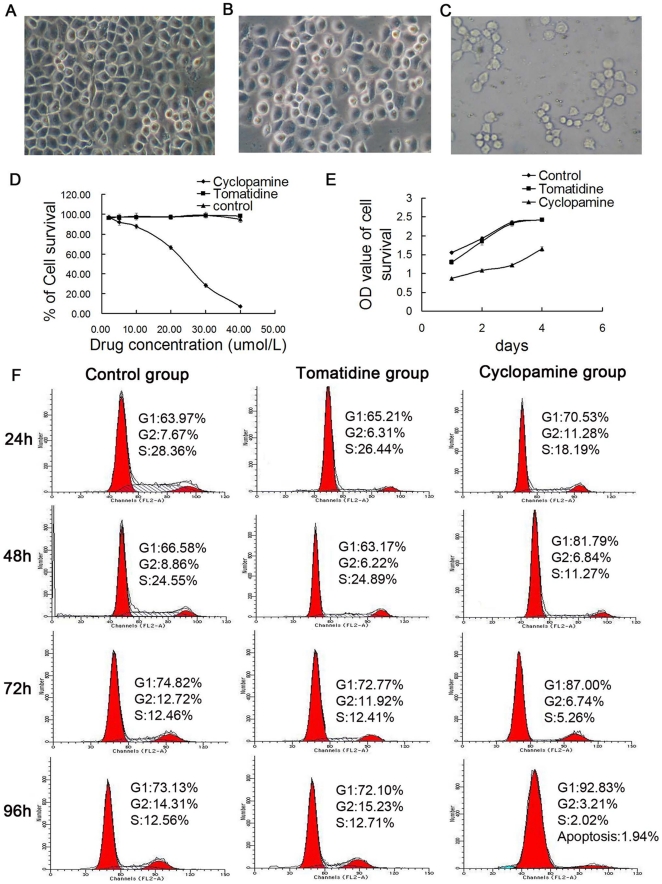
Cyclopamine inhibits H460 cell proliferation.A–C, Representative photomicrographs of H460 cells 72 h after treatment with vehicle control (A), Tomatidine (B), or Cyclopamine (C). Original maginifications: ×200. D, Cyclopamine dose-dependently inhibited H460 cell proliferation (P<0.05; one-way ANOVA). E, Time course of Cyclopamine inhibition of H460 cells (P<0.05, one-way ANOVA). Cyclopamine was used at 20 µmol/L. F, Effects of Cyclopamine on the cell cycle of H460 cells.